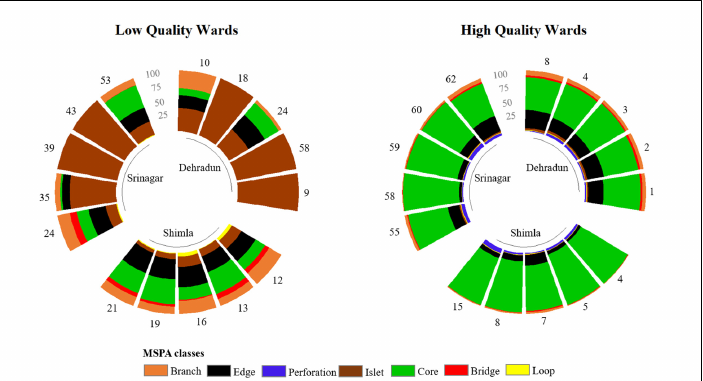
Land 2023 , 12 , x FOR PEER REVIEW Figure 10. Distribution of MSPA classes in selected wards (low and high quality) in the three cities. In high UGIQ wards, the percentage of areas covered by UGI varies greatly (ranging between 49–93% in Srinagar, 52–67% in Dehradun, and 79–92% in Shimla). The results in Figure 10 show that the high percentage of core areas (Shimla > Srinagar > Dehradun) substantially contribute to their respective UGIQ. What is important is the predominance of core followed by edge class, which is a good evidence of high quality UGI, as the com ‐ bination of these two classes ensures higher interaction with large natural patches. The perforation class is higher in the case of Srinagar and Shimla followed by the branch. In Dehradun, the branch class has a higher contribution followed by equal contributions of the islet and bridge classes. Loop is the least contributing class in all cities.